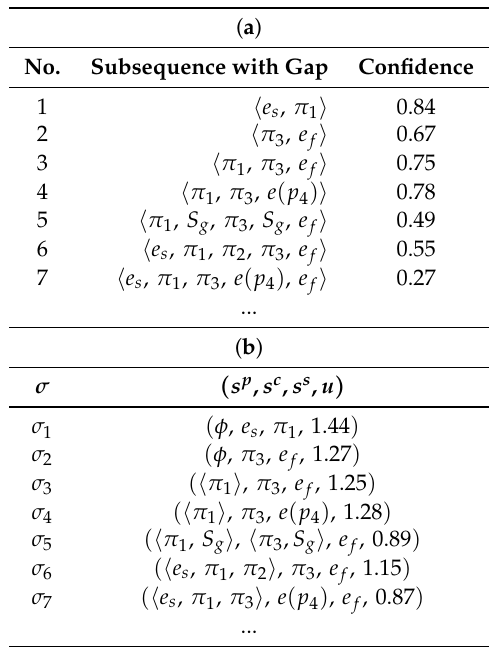
Table 4. Examples of the: ( a ) results of the cSPADE algorithm, as well as their confidences; and ( b ) GSTP